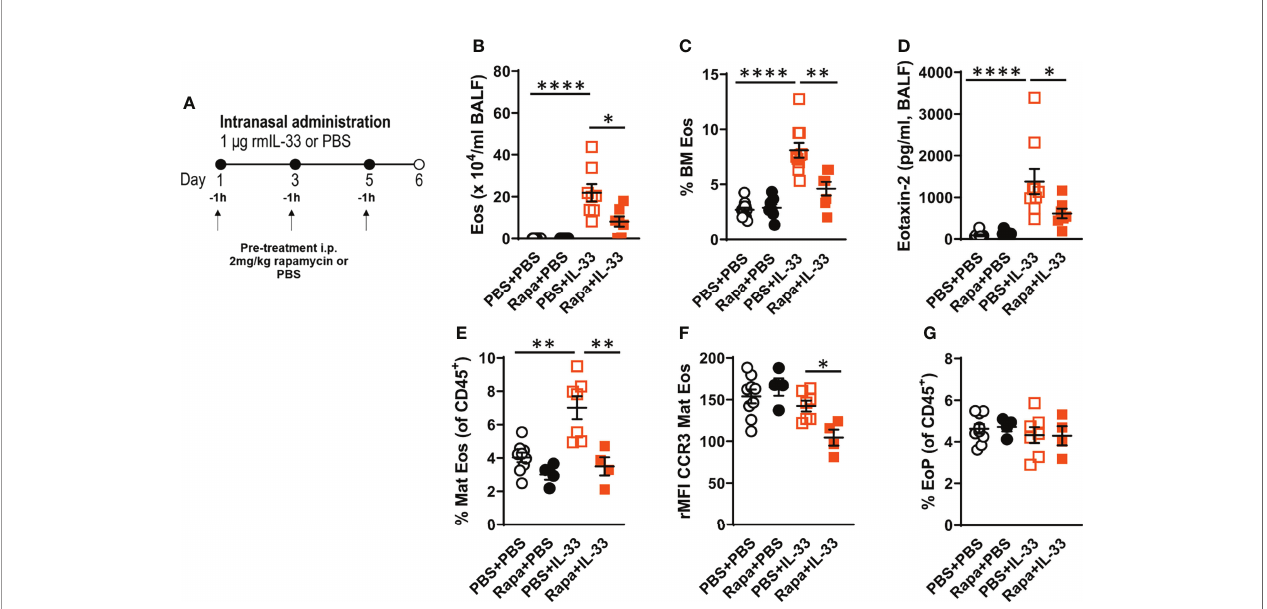
FIGURE 1 | Rapamycin reduced IL-33-induced eosinophilia in BALF and bone marrow. (A) C57BL/6 male mice received rapamycin or PBS i.p. one hour before intranasal challenges of rmIL-33 or PBS. Analysis was performed 24 h after the fi nal challenge. (B) Number of eosinophils in BALF and (C) bone marrow assessed by differential cell count. (D) CCL24/Eotaxin-2 concentration in BALF quanti fi ed by ELISA. (E) Number of mature eosinophils among all CD45 + leukocytes in the bone marrow. (F) CCR3 expression on mature eosinophils measured by relative mean fl uorescence intensity (rMFI). (G) Number of eosinophil progenitors among all CD45 + leukocytes in the bone marrow. Data are representative of 1 – 3 independent experiments (4 – 12/group) and displayed as mean ± SEM. Mann-Whitney U test. *P < 0.05, **P < 0 .01 and ****P < 0.0001. Eos, Eosinophil; BM, Bone marrow; Mat Eos, Mature eosinophil; EoP, Eosinophil progenitor; Rapa, Rapamycin; i.p, intraperitoneal; i.n., intranasal; PBS+PBS, PBS i.p. and PBS i.n; Rapa+PBS, Rapa i.p. and PBS i.n.; PBS+IL-33, PBS i.p. and IL-33 i.n.; Rapa+IL-33, Rapa i.p. and IL-33